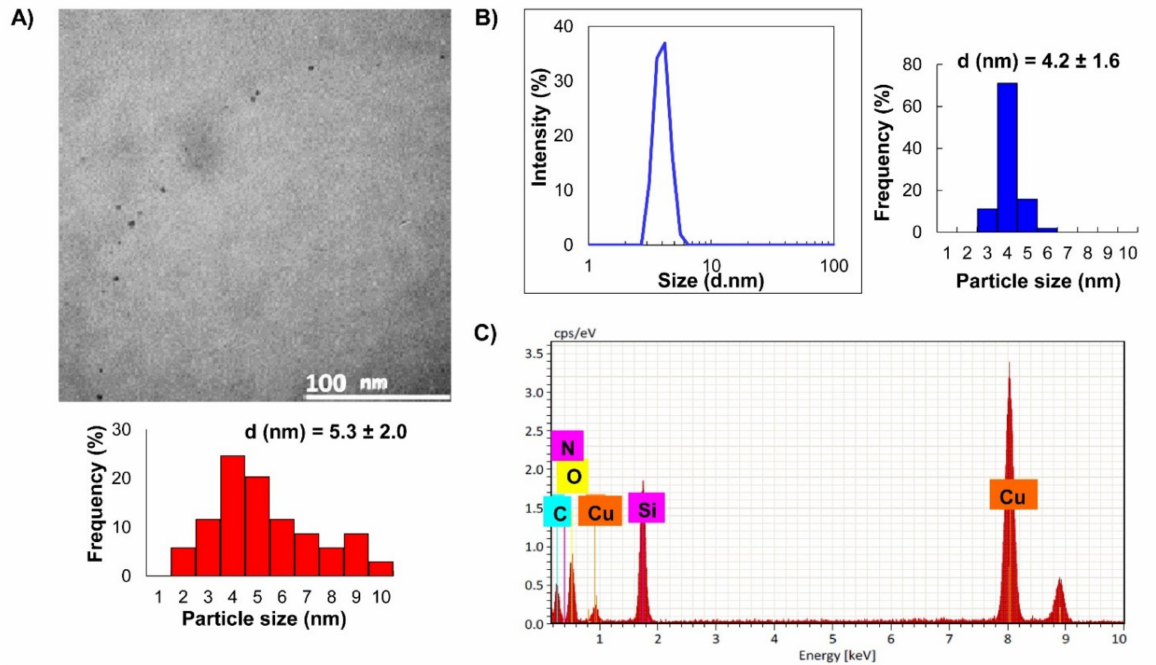
Figure 1. ( A ) Scanning transmission electron microscopy (STEM) image (top) and the size distribution histogram (bottom), ( B ) Size distribution of CDs and the corresponding size distribution histogram obtained by DLS, and ( C ) EDS results for